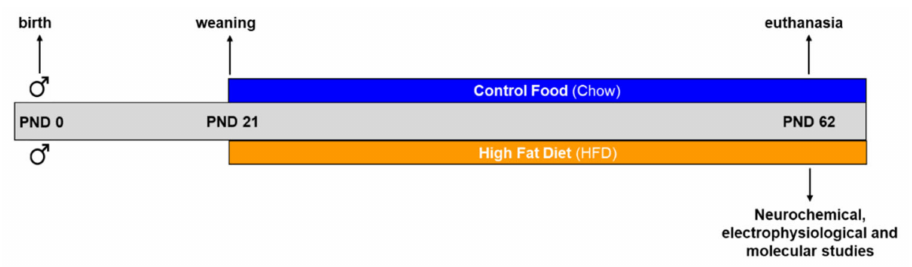
Figure 6. Schematic description of the exposure to diets, the most important milestones, and the experiments carried